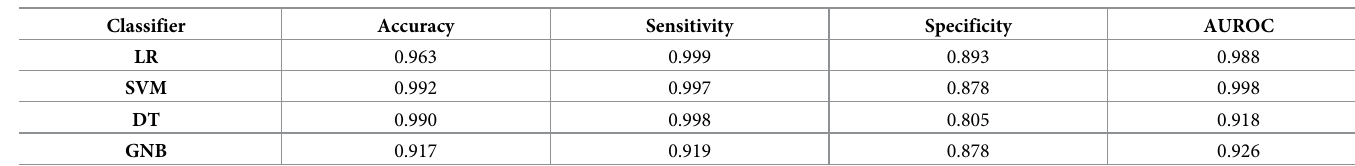
Table 3. Classifiers’ predictive performance in the testing set.